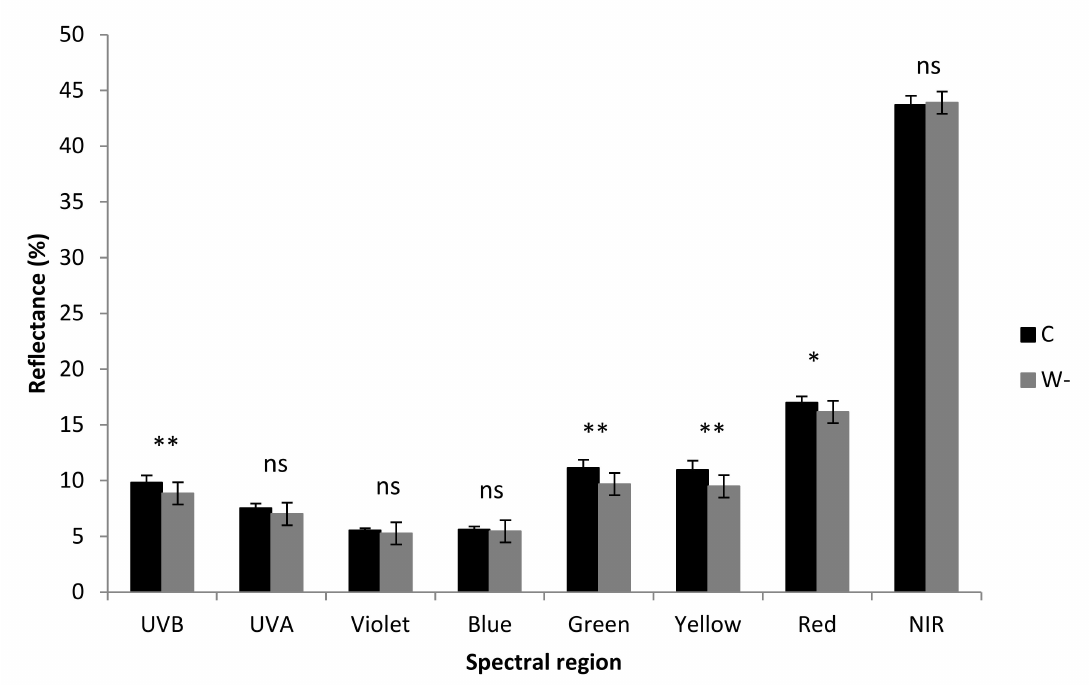
Figure 8. Leaf reflectance of the control (C) and water shortage (W-) treatments of the buckwheat plants. Data are means ± standard deviation ( n = 7). *, p ≤ 0.05; **, p ≤ 0.01 ( t -test); ns—not